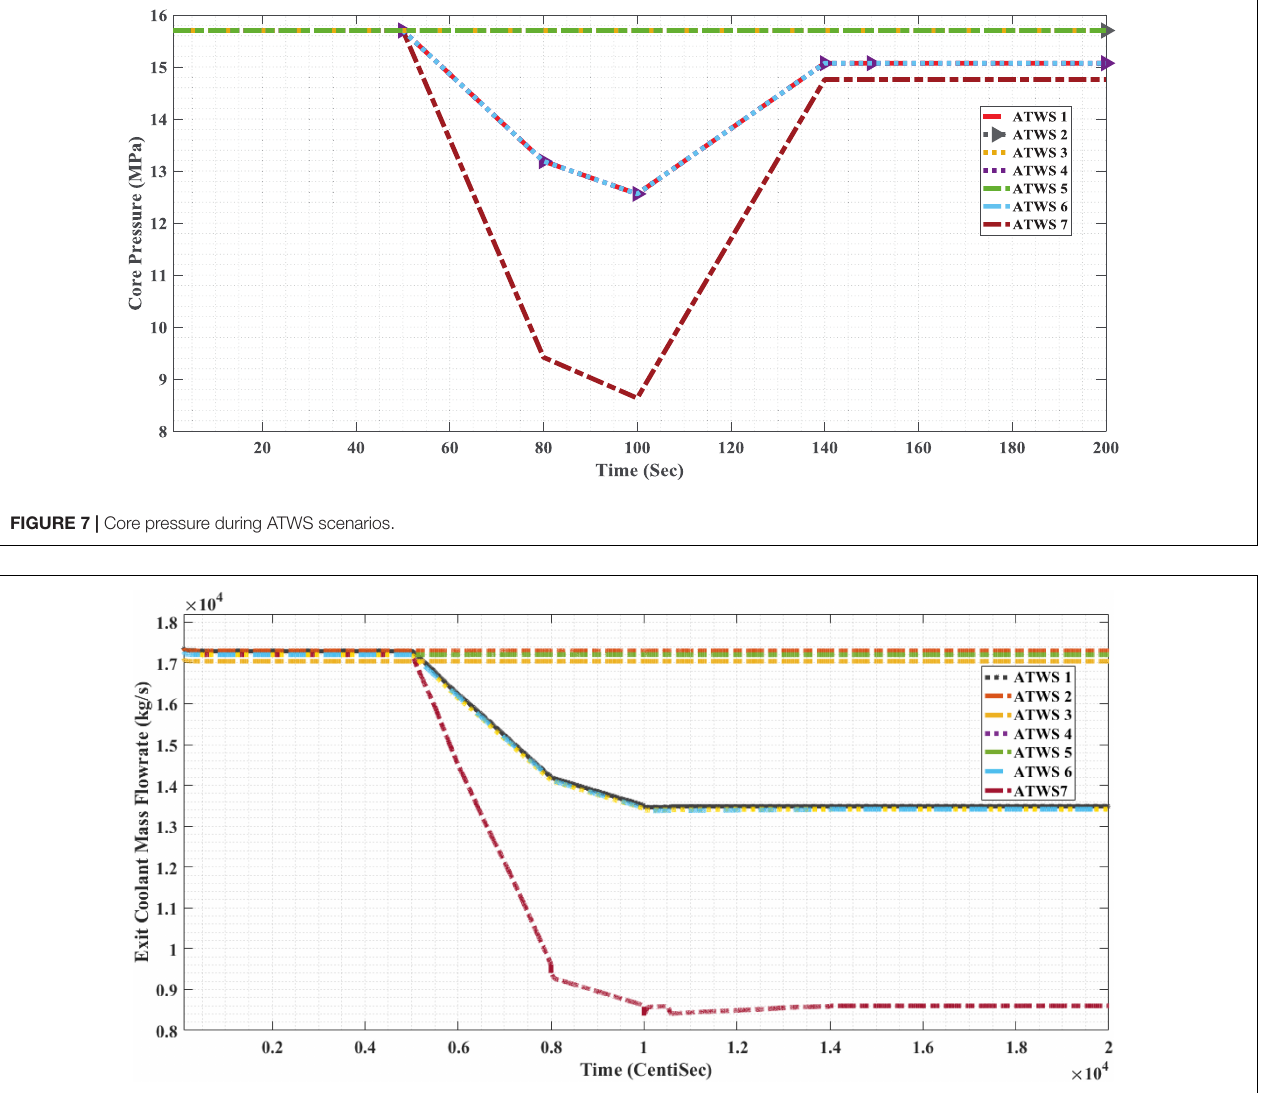
FIGURE 8 | Outlet coolant mass flow rate during ATWS